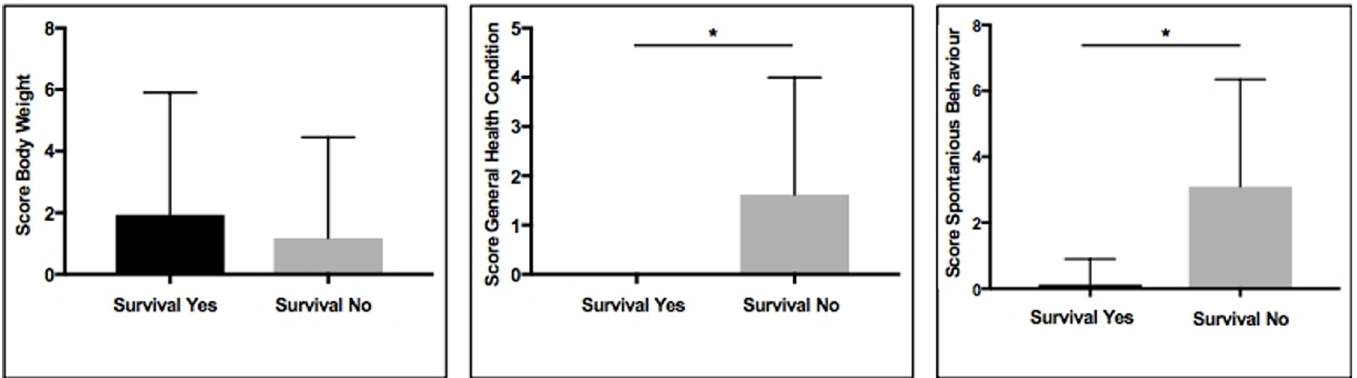
Fig 12. a-c: Graphical illustration showing the correlation between postoperative scoring parameters and survival. Displayed are in detail body weight (a), general health condition (b) and spontaneous behavior (c), with the mean score on the y-axis and survival on the x-axis.